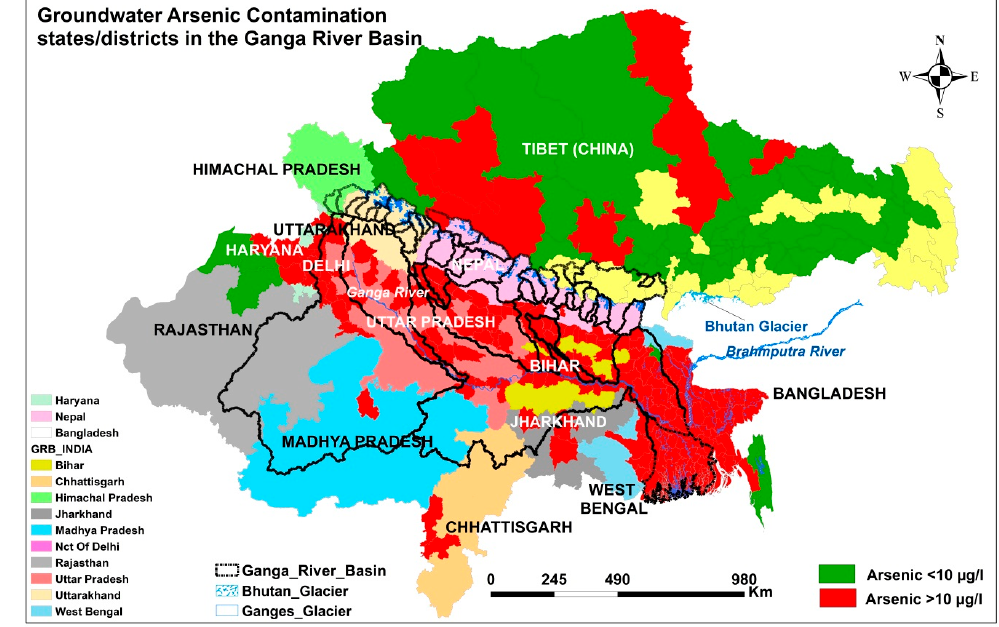
Figure 1. Current status of groundwater arsenic contamination in the GRB.